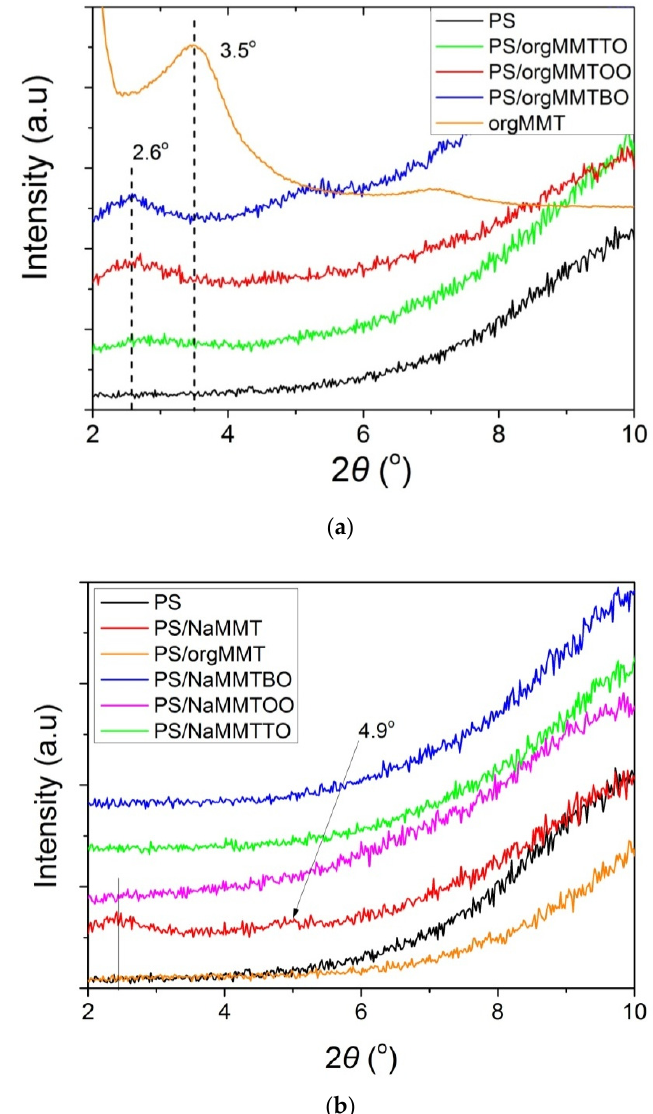
Figure 2. XRD patterns of organomodified MMT (orgMMT), neat PS and PS with 3% orgMMTEO nanocomposites ( a ) and of PS with NaMMTEO nanocomposites ( b ) focusing on the 2 θ range from 2 ◦ to 10 ◦ .